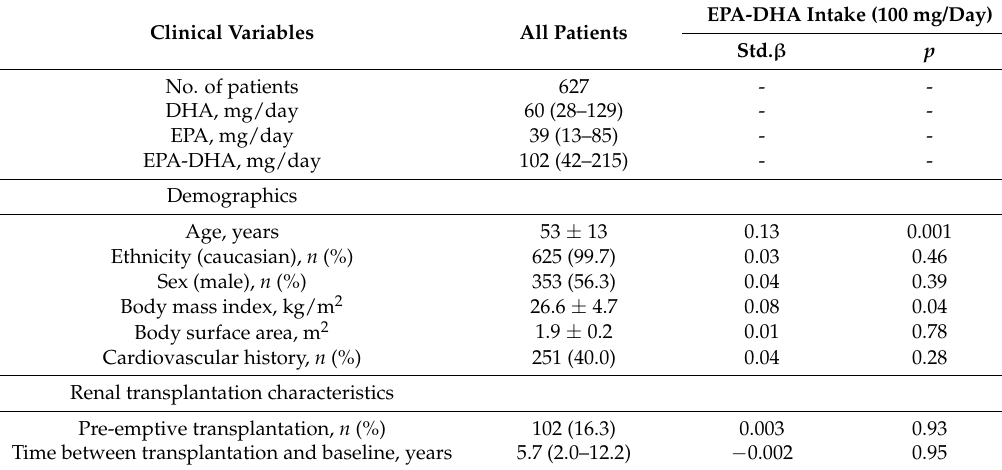
Table 1. Baseline characteristics of RTR, and association of energy adjusted EPA-DHA intake across clinical